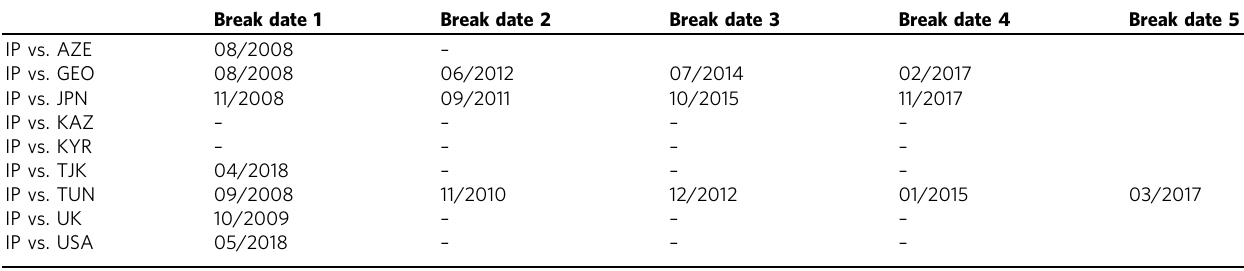
Table 9 Detection of break dates in DCCs of nine beef-importing countries.